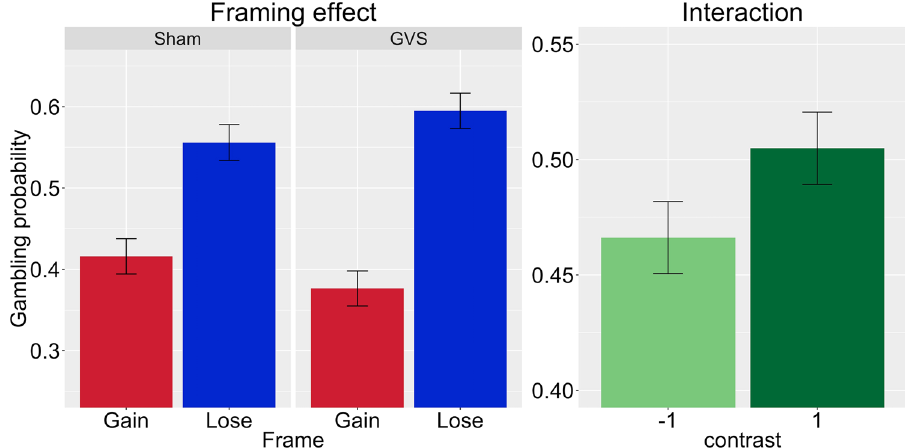
Figure 1. Results of Experiment 1: The left figure shows the framing effect as a function of galvanic vestibular stimulation (left anodal/right cathodal GVS) condition. The right figure shows the interaction term using contrast coding. Using a hierarchical logistical regression model, we found a significant interaction between stimulation and framing condition in Experiment 1.